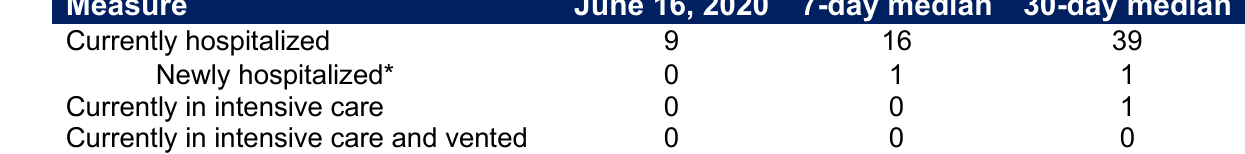
Table 3. COVID-19 volume, Ottawa hospitals (includes patients who live outside of